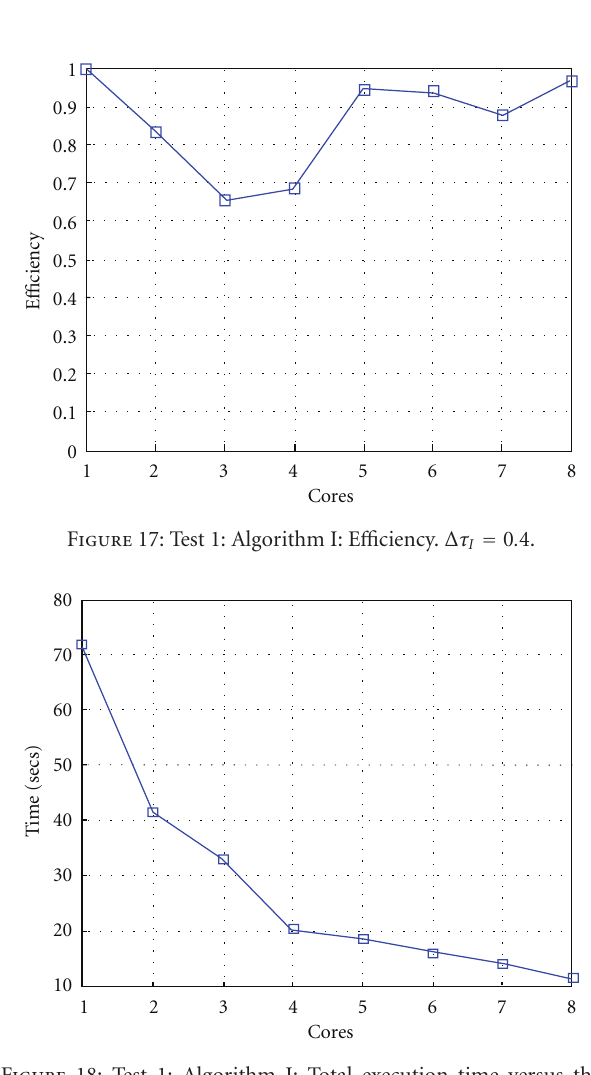
Figure 18: Test 1: Algorithm I: Total execution time versus the number of cores. Δ τ I = 0 . 04.